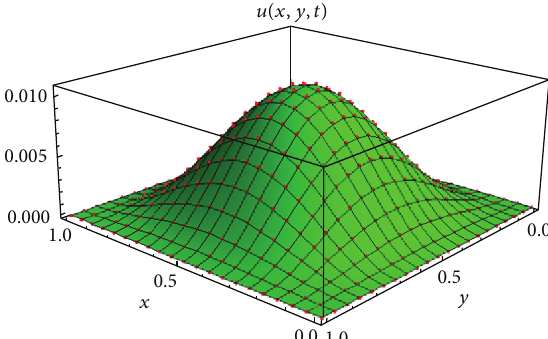
Figure 2: Exact solutions and numerical solutions with 𝜎 = 𝜌 = 1/1000 and 𝜏 = ℎ = 1/320 at 𝑇 = 1.0